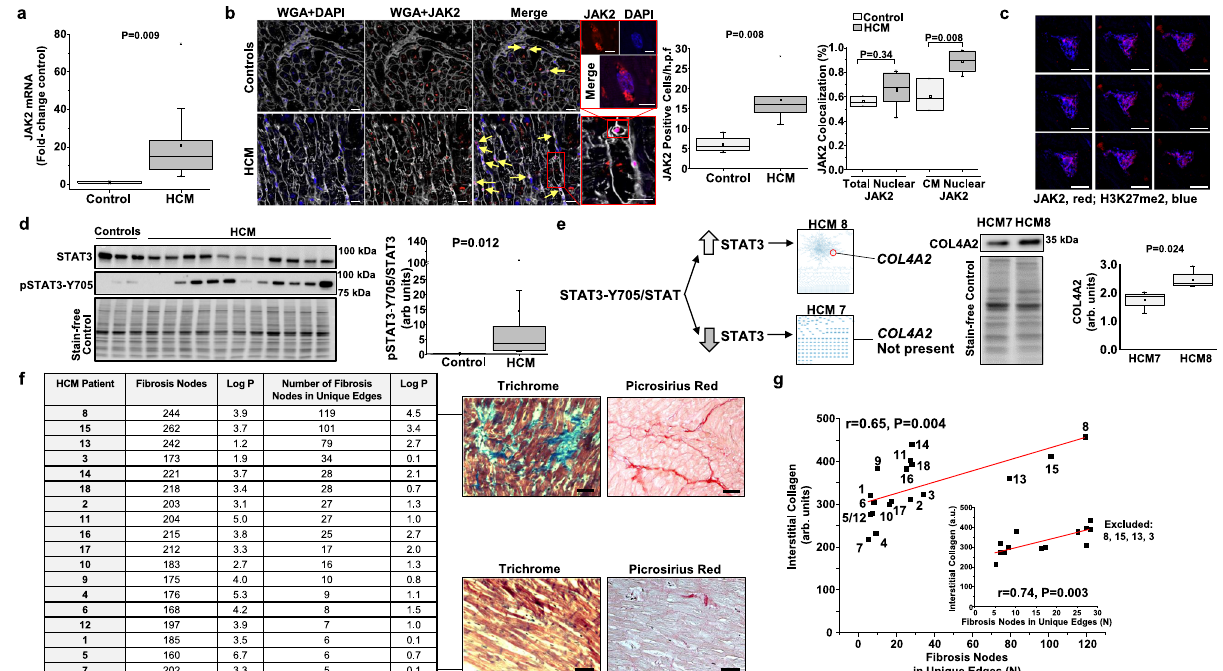
Fig. 3 Individual-patient network features inform the HCM fi brosis pathophenotype. Janus kinase-2 (JAK2) was one of four pro fi brotic nodes differentially expressed between HCM and control patients that was also present in all HCM patient networks. a In left ventricular (LV) homogenates, JAK2 mRNA quantity was increased signi fi cantly in HCM ( N = 16) compared with control ( N = 3), b which was consistent with anti-JAK2 immuno fl uorescence demonstrating increased JAK2-positivity of cells (yellow arrows), c as well as increased nuclear JAK2 expression in cardiomyocytes (supported by Z-stack imaging) ( N = 3 for controls; N = 7 for HCM). WGA, wheat germ agglutinin; H3K27me2, methylated lysine 27 of histone H3, and DAPI show nuclear signal. Scale bar = 20 µ m, and 6 µ m for inset/Z-stack images. d Increased LV homogenate p-STAT3-Y705/total STAT3 was observed in HCM ( N = 11) compared with control ( N = 3). HCM patients 8 and 7 had the greatest and least p-STAT3-Y705/total STAT3 ratio, respectively, and the STAT3 collagen target COL4A2 was present in the HCM8 network, but absent from the HCM7 network. e Analysis of collagen gene variants suggested a particular difference between HCM8 and HCM7 for COL4A-218, which was con fi rmed by immunoblot. Immunoblot images are within the same blot, but cropped and merged ( N = 4 samples/condition). f The total number of fi brosis nodes and the number ( N ) of fi brosis nodes in edges unique to a single HCM patient network were calculated. Histopathology con fi rmed that HCM8 and HCM7 represent extreme fi brosis pathophenotypes. Scale bar = 50 µ m. g The relationship between the number of unique fi brosis edges for each patient network and interstitial collagen quantity by trichrome stain, which was maintained after excluding the most densely connected patient networks ( N = 4 removed from analysis, shown in inset). The HCM patient number is provided with each datapoint. Representative micrographs and blots are shown. a – e , g Student ’ s unpaired two-tailed t test or Mann – Whitney tests were used as appropriate. a , b , d , e box plots: mean (square), median (horizontal line), interquartile range (box distribution), and maximum and minimum (stars). f The one-tail hypergeometric test was used to generate the log P values. g For linear regression, Pearson ’ s correlation coef fi cient is presented. Source data are